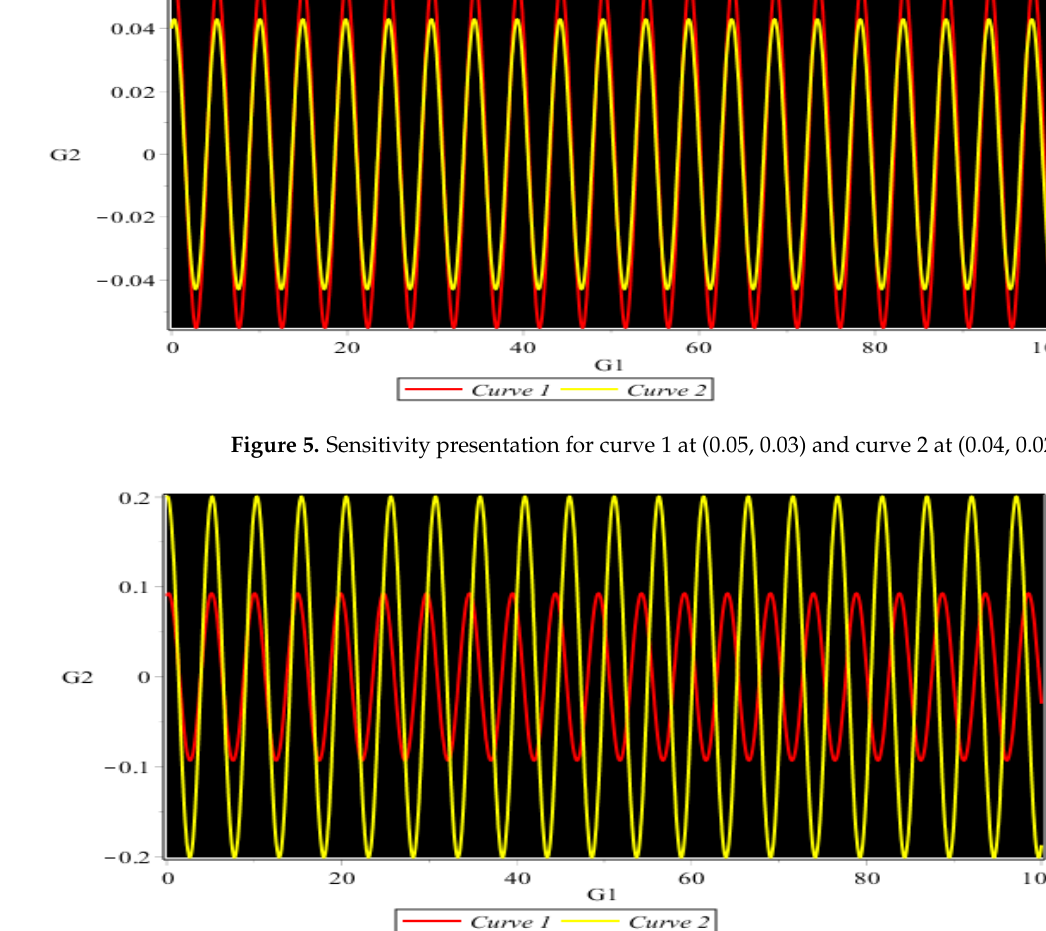
Figure 7. Sensitivity presentation for curve 1 at (0.04, 0.03) and curve 2 at (0.4, 0.02). 6. Sensitive Visualization In this section, the sensitivity analysis is performed to investigate the sensitivity of the complex Ginzburg-Landau equation in Kerr law media using the computational soft- ware MAPLE. The Galilean transformation is applied to the ODE and obtains a dynamical system as given below.